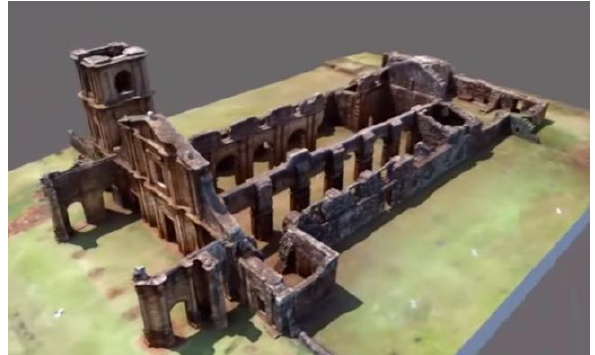
Figure 12. Fusion of 3D models produced by Photogrammetry and TLS (Reiss et al, 2016).